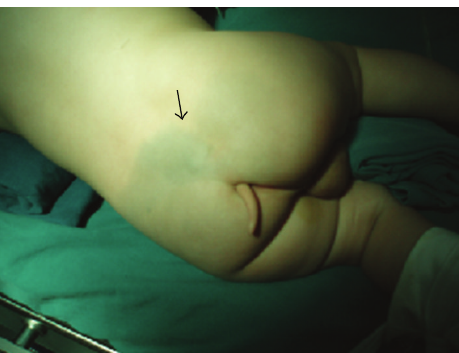
Figure 1: Photography of the infant showing the appendage was attached to the back tip of coccyx appearing like a human tail and a dark pigmentation area in the low